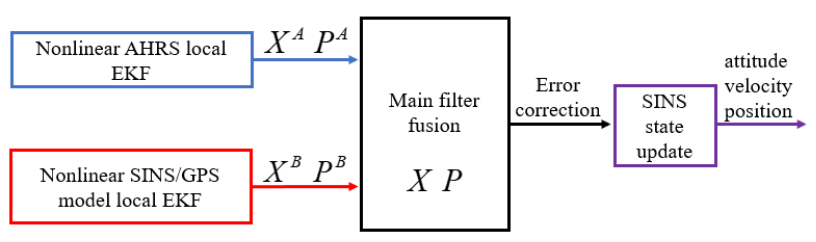
Figure 4. The federated DMEKF (Double Model EKF) fusion diagram.